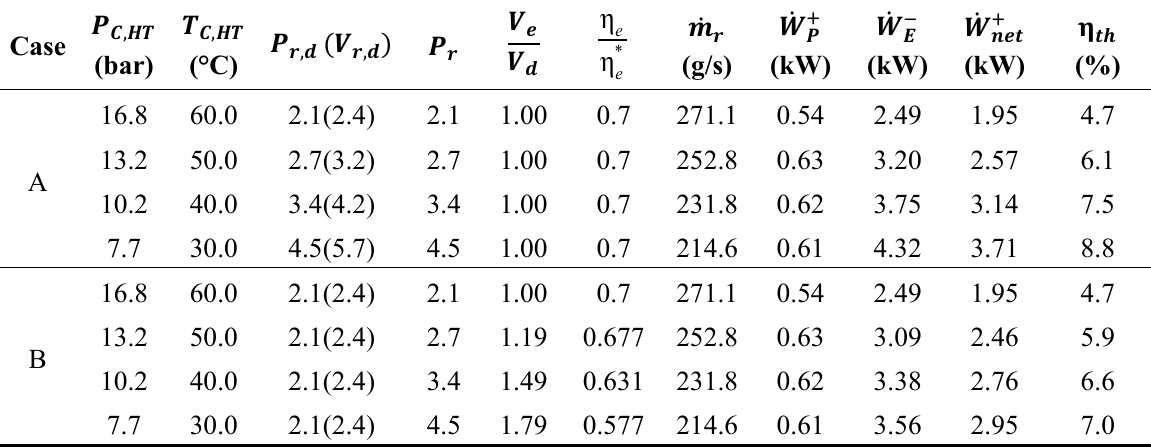
Table 2. Operation characteristics of the LT cycle (A) with varying expander P r , d (= P r ) and decreasing T C , LT and (B) for the under-expansion state with P r , d fixed to 2.1, varying P r , and decreasing T C , LT